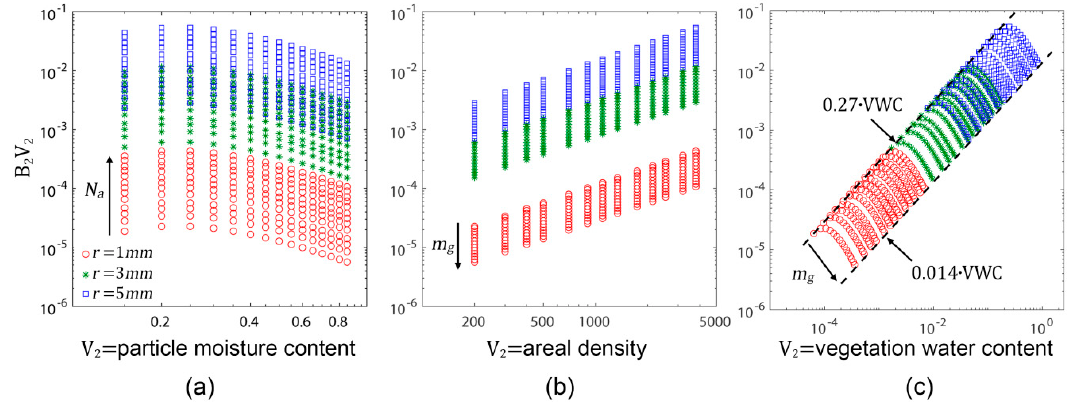
Figure 2. Variations of B 2 V 2 in the case of spherical particles as a function of ( a ) the particle moisture content ( m g ), ( b ) the areal density ( N a ), and ( c ) the vegetation water content (VWC).